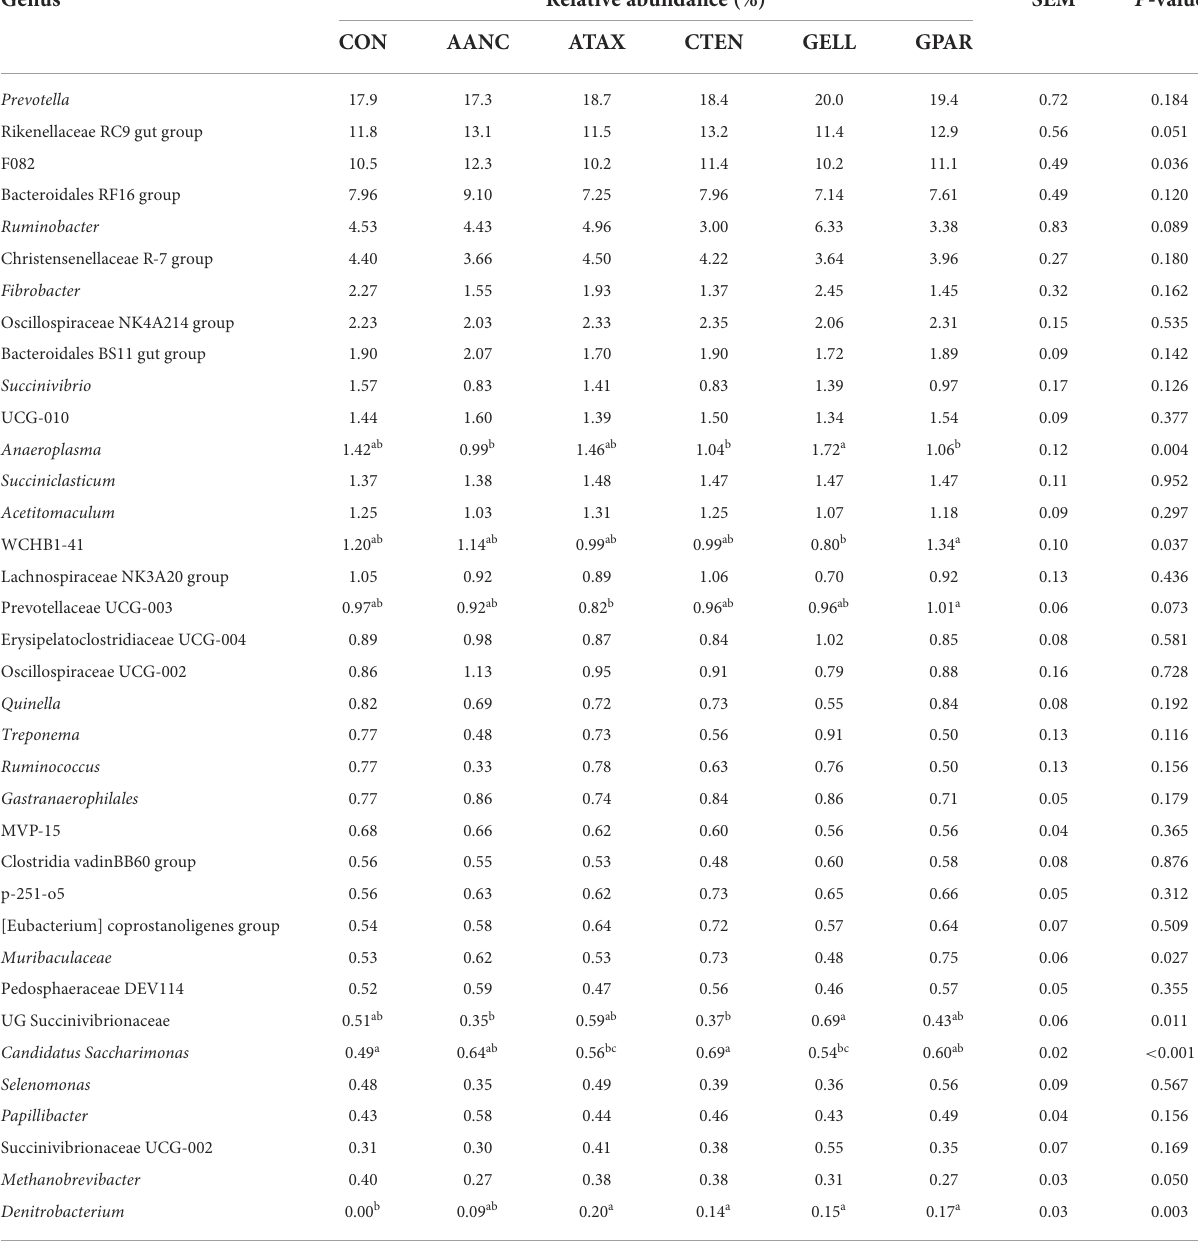
TABLE 3 Major genera of bacteria (relative abundance > 0.1%) in response to supplementation of red seaweed extracts after 24h of in vitro incubation.